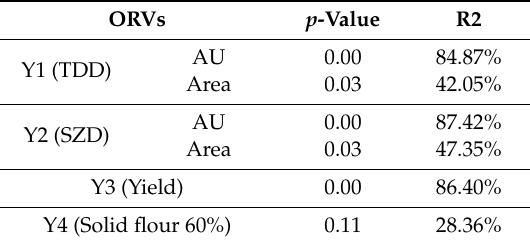
Table 3. Response surface analysis result.